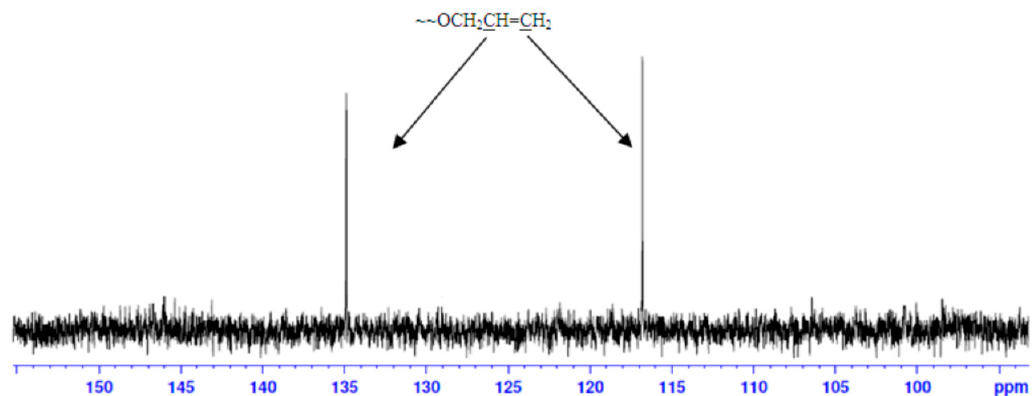
Figure 2. 13 C NMR spectrum of PPO-diol (1) showing signals of unsaturated allyloxy starting groups.